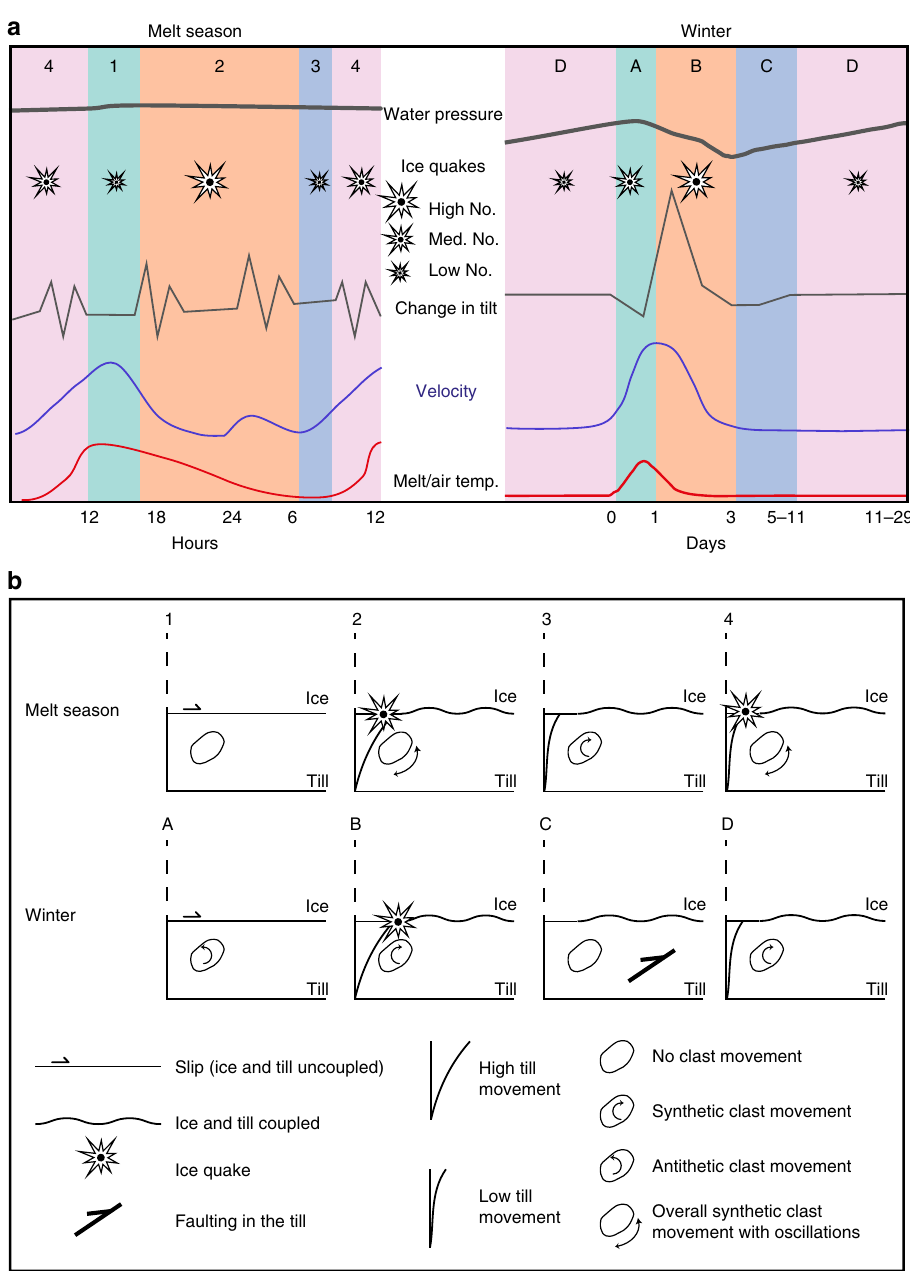
Fig. 8 Schematic diagram to demonstrate the four stages of stick-slip behaviour in the different seasons. a This shows a graphical representation of water pressure, icequakes, tilt change direction, glacier horizontal velocity and meltwater input during a melt season (diurnal) and winter (multi-day) cycle. Melt season stages: 1 — sliding, 2 — reconnection, 3 — minimum deformation and 4 — reactivation; winter stages: A — sliding, B — reconnection, C — stick and D — reactivation. Icequakes represented as percentage of the total over the cycle: low number = <15%, medium number = 15 – 60%, high number = >60%. Change in tilt represented as follows: up = synthetic movement, down = antithetic movement, zig-zag = oscillatory movement associated with